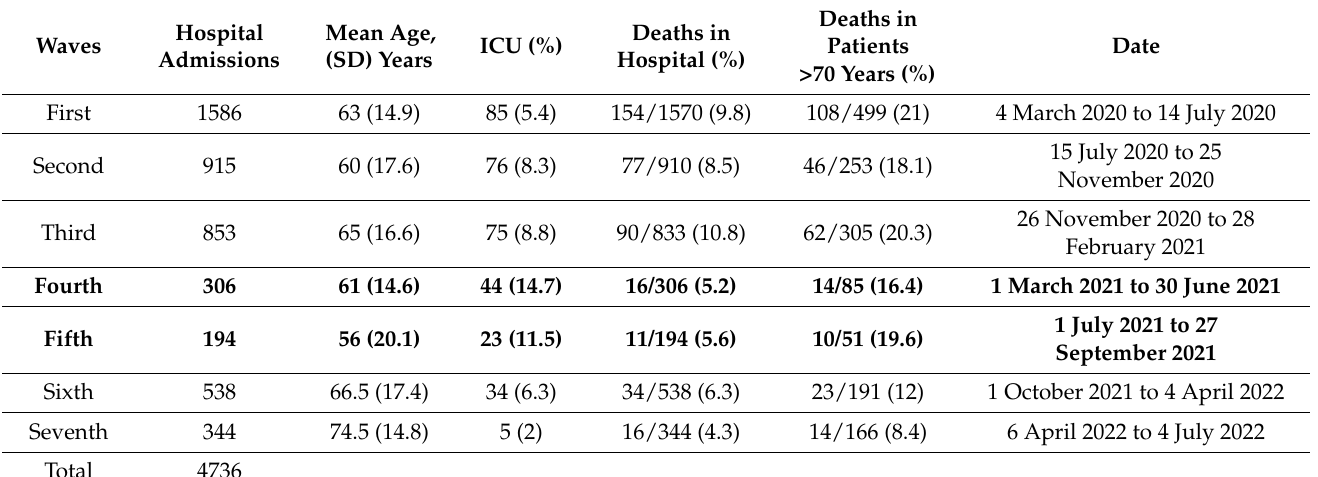
Table 1. Hospital admissions, mean age of patients, ICU admissions, and deaths in hospital due to COVID-19 patients in HUF along the seven pandemic waves.